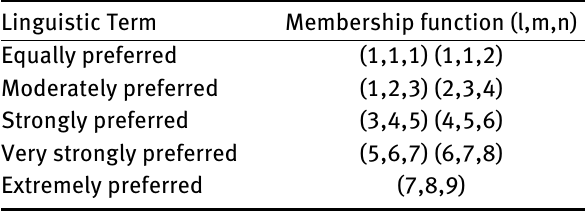
Table 4: Triangular Fuzzy conversion